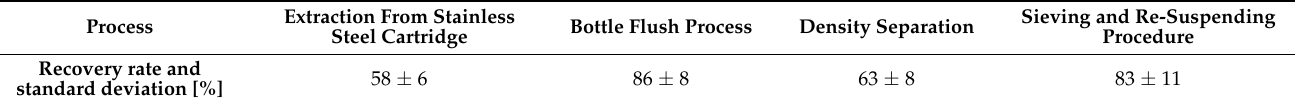
Table 2. Recovery rates determined with 95–145 µ m PS particles for all sample preparation steps.